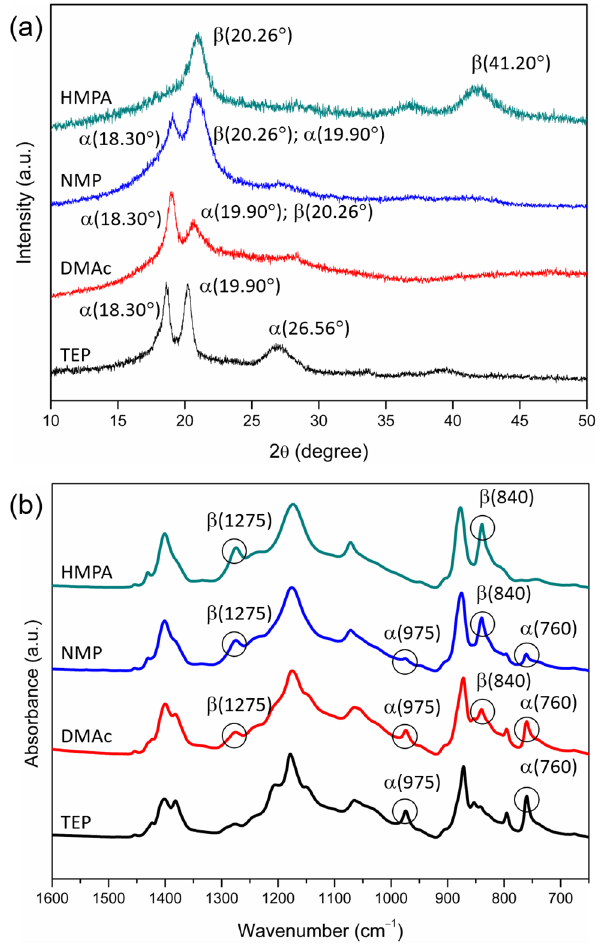
Figure 5. XRD ( a ) and FTIR/ATR ( b ) spectra of the surfaces of PVDF membranes prepared with nonsolvent-induced phase separation, with HMPA, NMP, DMAc or TEP used as the solvent to dissolve PVDF.